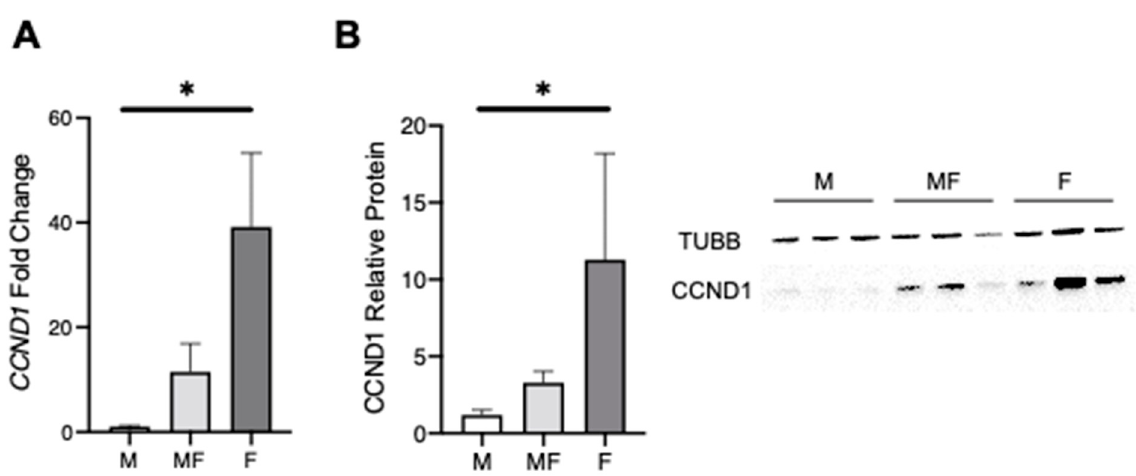
Figure 5. CCND1 gene and protein expression in myometria from non-fibroid patient (M), fibroid (F) and matching myometria (MF). ( A ) Relative expression of CCND1 by qRT-PCR compared with the RPL17 housekeeping gene in M, MF and F ( n = 5–6/group), * p -value = 0.01. ( B ) Representative western blot and quantification of the relative protein expression of CCND1 normalized to TUBB in M, MF and F tissues ( n = 6/group), * p -value = 0.01.